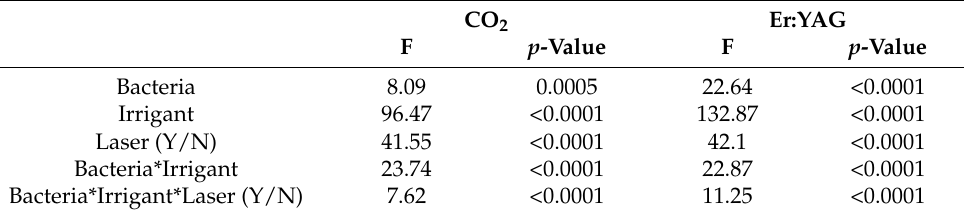
Table 1. Model results.